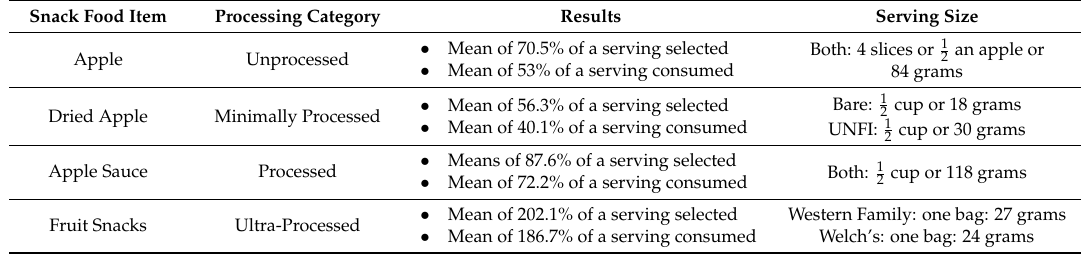
Figure 3. Linear relationship between the apple snack food selection and consumption. Table 7. Results from the selection and consumption data originally recorded in grams and calculated into a percentage of a serving as specified on the product packaging.